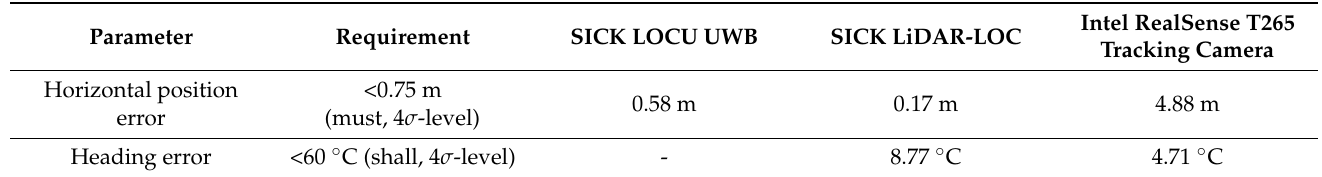
Table 7. Comparison of requirements and respective performance metrics of the SUT for the process “global